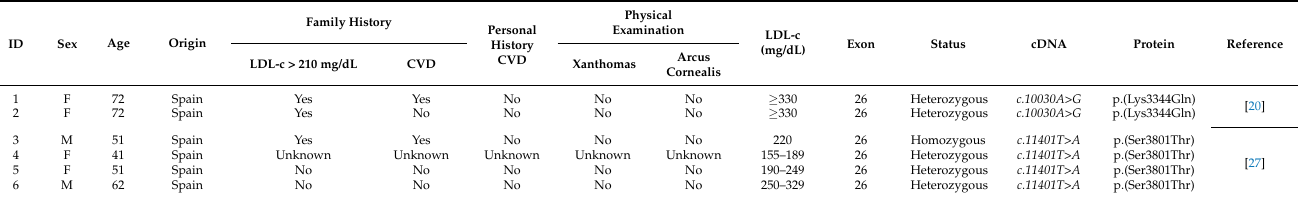
Figure 1. Flow diagram of the study process. The variants characterized are underlined. Table 1. Characteristics of the patients and description of the APOB variants characterized.